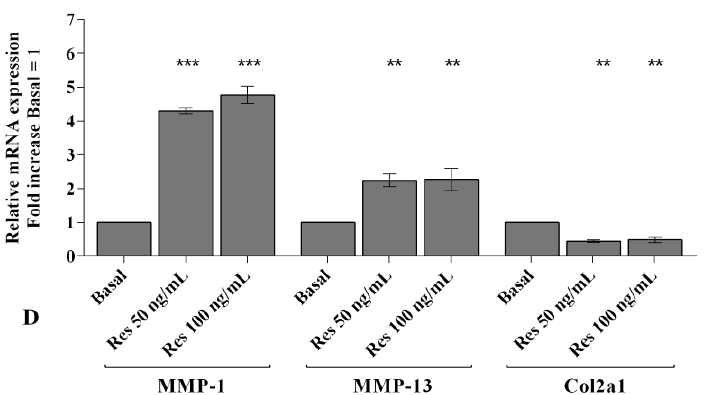
Figure 1. ( A – D ) Expression levels of interleukin ( IL ) -1β , IL-6 , IL-17A , tumor necrosis factor ( TNF )- α ,